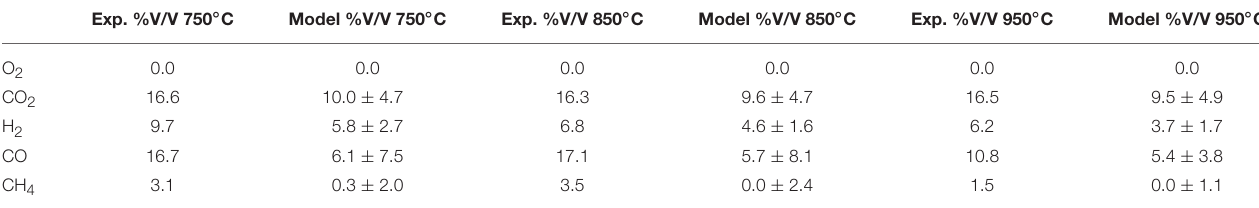
TABLE 4 | Experimentally derived and model predicted product gases at the three selected